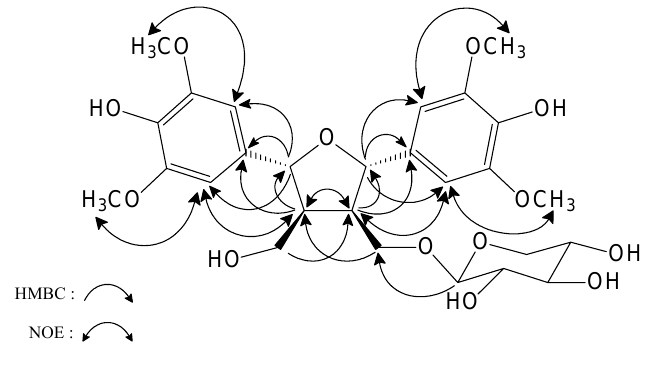
Figure 2. HMBC and NOE Correlations of compound 1